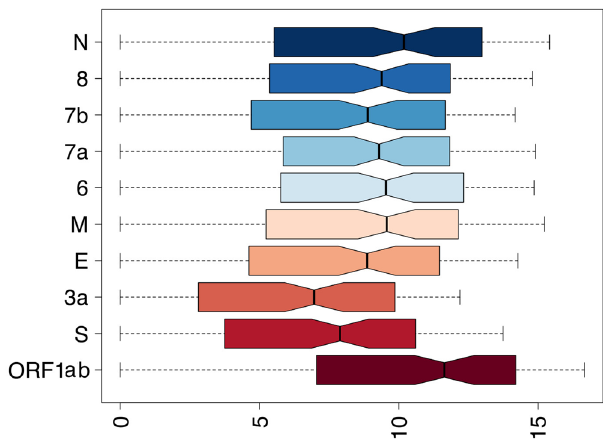
Fig. 4 SARS-CoV-2 transcripts expression derived from meta- transcriptomics sequencing. Representation by boxplots of log2 scaled counts distributions of meta-transcriptomics reads assigned to each sgmRNAs and to the ORF1ab gene (gRNA). Genes are indicated on the Y - axis. Log2 scaled counts on the X